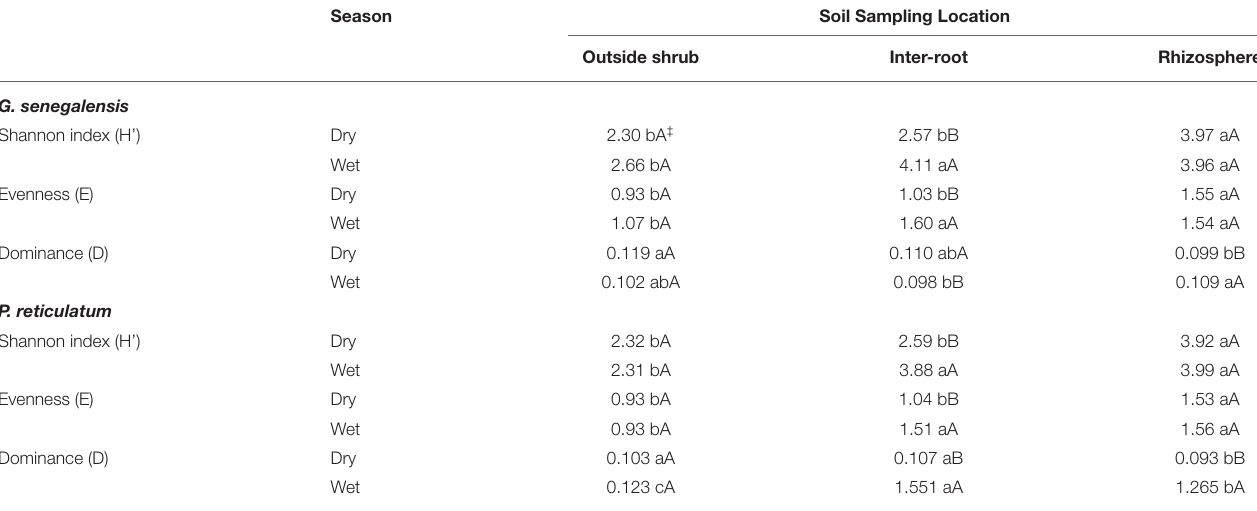
TABLE 2 | Diversity indexes based on PLFA